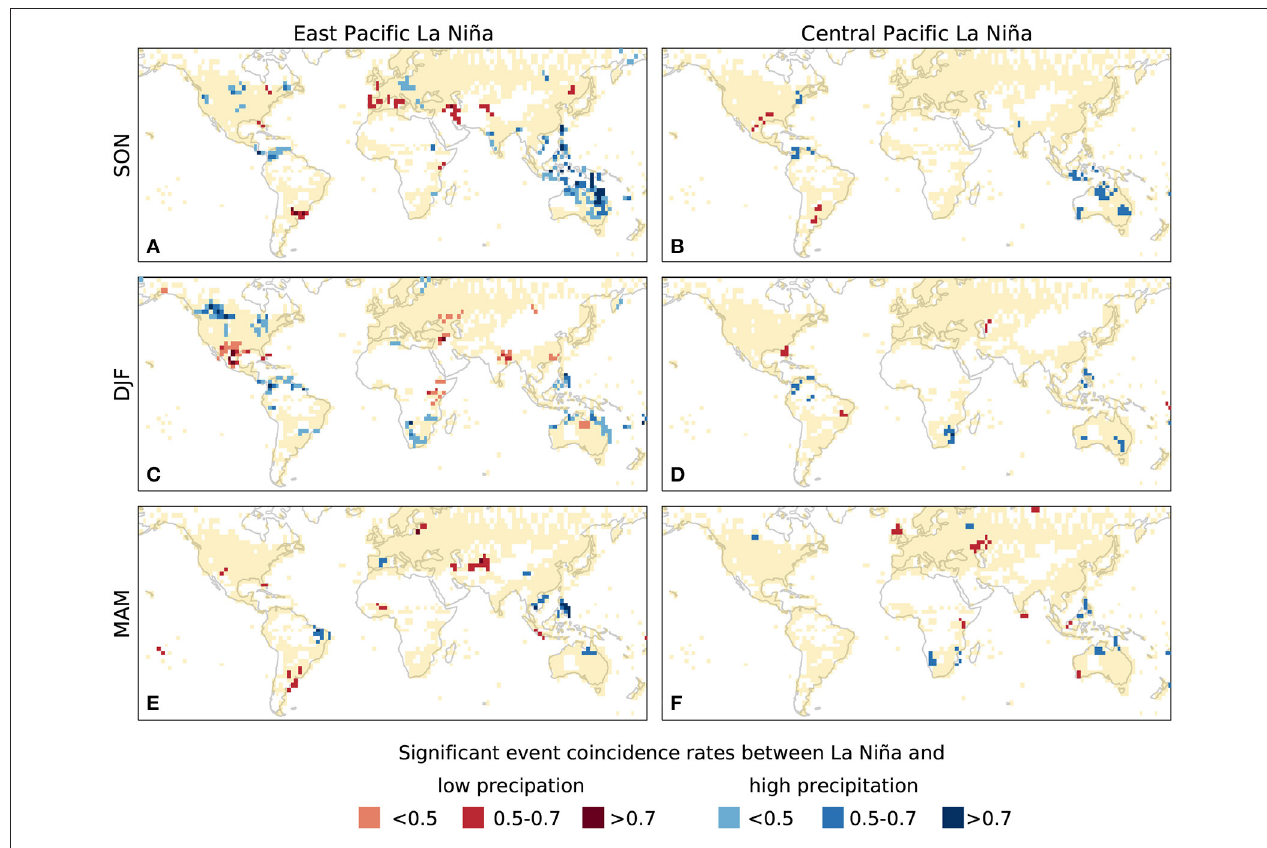
FIGURE 4 | Same as Figure 3 , but for the two types of La